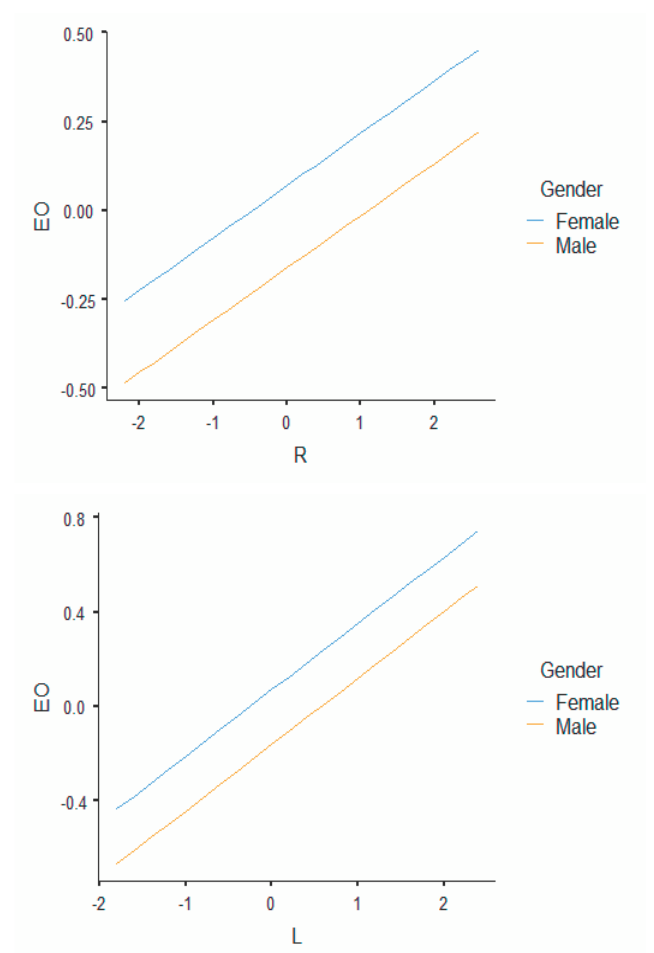
Figure 4. (cid:3)(cid:40)(cid:86)(cid:87)(cid:76)(cid:80)(cid:68)(cid:87)(cid:72)(cid:71)(cid:3)(cid:48)(cid:68)(cid:85)(cid:74)(cid:76)(cid:81)(cid:68)(cid:79)(cid:3)(cid:48)(cid:72)(cid:68)(cid:81)(cid:86)(cid:3)(cid:178)(cid:3)(cid:40)(cid:71)(cid:88)(cid:70)(cid:68)(cid:87)(cid:76)(cid:82)(cid:81)(cid:3)(cid:50)(cid:88)(cid:87)(cid:70)(cid:82)(cid:80)(cid:72)(cid:86)(cid:15)(cid:3)(cid:53)(cid:72)(cid:68)(cid:71)(cid:76)(cid:81)(cid:74)(cid:3)(cid:68)(cid:70)(cid:87)(cid:76)(cid:89)(cid:76)(cid:87)(cid:92)(cid:15)(cid:3) (cid:47)(cid:68)(cid:81)(cid:74)(cid:88)(cid:68)(cid:74)(cid:72)(cid:3)(cid:40)(cid:91)(cid:83)(cid:72)(cid:85)(cid:76)(cid:72)(cid:81)(cid:70)(cid:72)(cid:86)(cid:15)(cid:3)(cid:42)(cid:72)(cid:81)(cid:71)(cid:72)(cid:85)(cid:17) (cid:49)(cid:82)(cid:87)(cid:72) (cid:29)(cid:3)(cid:40)(cid:50)(cid:16)(cid:40)(cid:71)(cid:88)(cid:70)(cid:68)(cid:87)(cid:76)(cid:82)(cid:81)(cid:3)(cid:50)(cid:88)(cid:87)(cid:70)(cid:82)(cid:80)(cid:72)(cid:86)(cid:3)(cid:54)(cid:70)(cid:82)(cid:85)(cid:72)(cid:15)(cid:3)(cid:53)(cid:16)(cid:53)(cid:72)(cid:68)(cid:71)(cid:76)(cid:81)(cid:74)(cid:3)(cid:36)(cid:70)(cid:87)(cid:76)(cid:89)(cid:76)(cid:87)(cid:92)(cid:3)(cid:54)(cid:70)(cid:82)(cid:85)(cid:72)(cid:15)(cid:3)(cid:47)(cid:16)(cid:47)(cid:68)(cid:81)(cid:74)(cid:88)(cid:68)(cid:74)(cid:72)(cid:3)(cid:40)(cid:91)(cid:83)(cid:72)(cid:85)(cid:76)(cid:72)(cid:81)(cid:70)(cid:72)(cid:86)(cid:3)(cid:54)(cid:70)(cid:82)(cid:85)(cid:72)(cid:17) (cid:55)(cid:75)(cid:72)(cid:3) (cid:86)(cid:72)(cid:70)(cid:82)(cid:81)(cid:71)(cid:3) (cid:80)(cid:82)(cid:71)(cid:72)(cid:79)(cid:3) (cid:76)(cid:81)(cid:70)(cid:79)(cid:88)(cid:71)(cid:72)(cid:71)(cid:3) (cid:86)(cid:87)(cid:88)(cid:71)(cid:92)(cid:3) (cid:85)(cid:72)(cid:86)(cid:88)(cid:79)(cid:87)(cid:86)(cid:3) (cid:86)(cid:70)(cid:82)(cid:85)(cid:72)(cid:3) (cid:68)(cid:86)(cid:3) (cid:71)(cid:72)(cid:83)(cid:72)(cid:81)(cid:71)(cid:68)(cid:81)(cid:87)(cid:3) (cid:89)(cid:68)(cid:85)(cid:76)(cid:68)(cid:69)(cid:79)(cid:72)(cid:3) (cid:68)(cid:81)(cid:71)(cid:3)(cid:85)(cid:72)(cid:68)(cid:71)(cid:76)(cid:81)(cid:74)(cid:3)(cid:68)(cid:70)(cid:87)(cid:76)(cid:89)(cid:76)(cid:87)(cid:92)(cid:15)(cid:3)(cid:90)(cid:85)(cid:76)(cid:87)(cid:76)(cid:81)(cid:74)(cid:3)(cid:68)(cid:70)(cid:87)(cid:76)(cid:89)(cid:76)(cid:87)(cid:92)(cid:3)(cid:68)(cid:81)(cid:71)(cid:3)(cid:79)(cid:76)(cid:81)(cid:74)(cid:88)(cid:76)(cid:86)(cid:87)(cid:76)(cid:70)(cid:3)(cid:72)(cid:91)(cid:83)(cid:72)(cid:85)(cid:76)(cid:72)(cid:81)(cid:70)(cid:72)(cid:86)(cid:3)(cid:68)(cid:86)(cid:3)(cid:70)(cid:82)(cid:89)(cid:68)(cid:85)(cid:76)(cid:68)(cid:87)(cid:72)(cid:86)(cid:17)(cid:3) (cid:42)(cid:72)(cid:81)(cid:71)(cid:72)(cid:85)(cid:3)(cid:90)(cid:68)(cid:86)(cid:3)(cid:88)(cid:86)(cid:72)(cid:71)(cid:3)(cid:68)(cid:86)(cid:3)(cid:68)(cid:3)(cid:80)(cid:82)(cid:71)(cid:72)(cid:85)(cid:68)(cid:87)(cid:76)(cid:81)(cid:74)(cid:3)(cid:73)(cid:68)(cid:70)(cid:87)(cid:82)(cid:85)(cid:3)(cid:11)(cid:70)(cid:82)(cid:71)(cid:76)(cid:81)(cid:74)(cid:29)(cid:3)(cid:20)(cid:16)(cid:73)(cid:72)(cid:80)(cid:68)(cid:79)(cid:72)(cid:15)(cid:3)(cid:19)(cid:16)(cid:80)(cid:68)(cid:79)(cid:72)(cid:12)(cid:17)(cid:3)(cid:53)(cid:72)(cid:86)(cid:88)(cid:79)(cid:87)(cid:86)(cid:3) (cid:82)(cid:73)(cid:3)(cid:87)(cid:75)(cid:72)(cid:3)(cid:79)(cid:76)(cid:81)(cid:72)(cid:68)(cid:85)(cid:3)(cid:85)(cid:72)(cid:74)(cid:85)(cid:72)(cid:86)(cid:86)(cid:76)(cid:82)(cid:81)(cid:3)(cid:83)(cid:85)(cid:82)(cid:89)(cid:72)(cid:3)(cid:87)(cid:75)(cid:68)(cid:87)(cid:3)(cid:87)(cid:75)(cid:72)(cid:3)(cid:70)(cid:85)(cid:72)(cid:68)(cid:87)(cid:72)(cid:71)(cid:3)(cid:80)(cid:82)(cid:71)(cid:72)(cid:79)(cid:3)(cid:11)(cid:41)(cid:11)(cid:23)(cid:15)(cid:3)(cid:21)(cid:22)(cid:19)(cid:12)(cid:32)(cid:21)(cid:17)(cid:24)(cid:27)(cid:15)(cid:3)(cid:53)(cid:242)(cid:32)(cid:19)(cid:17)(cid:19)(cid:23)(cid:15)(cid:3) (cid:83)(cid:32)(cid:17)(cid:19)(cid:22)(cid:27)(cid:12)(cid:3) (cid:76)(cid:86)(cid:3) (cid:86)(cid:76)(cid:74)(cid:81)(cid:76)(cid:192)(cid:70)(cid:68)(cid:81)(cid:87)(cid:15)(cid:3) (cid:76)(cid:81)(cid:71)(cid:76)(cid:70)(cid:68)(cid:87)(cid:76)(cid:81)(cid:74)(cid:3) (cid:79)(cid:68)(cid:81)(cid:74)(cid:88)(cid:68)(cid:74)(cid:72)(cid:3) (cid:72)(cid:91)(cid:83)(cid:72)(cid:85)(cid:76)(cid:72)(cid:81)(cid:70)(cid:72)(cid:86)(cid:3) (cid:11)(cid:87)(cid:32)(cid:21)(cid:17)(cid:19)(cid:24)(cid:15)(cid:3) (cid:83)(cid:32)(cid:17)(cid:19)(cid:23)(cid:20)(cid:12)(cid:3) (cid:68)(cid:81)(cid:71)(cid:3)